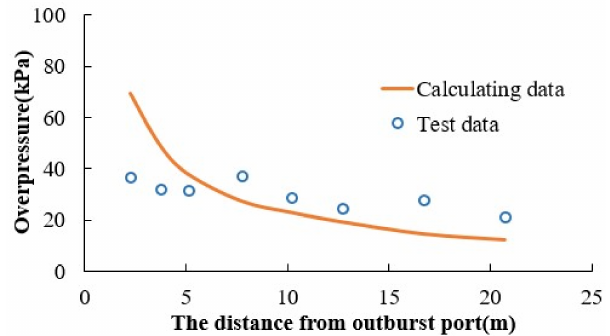
Figure 11. The relationship between shock wave overpressures and